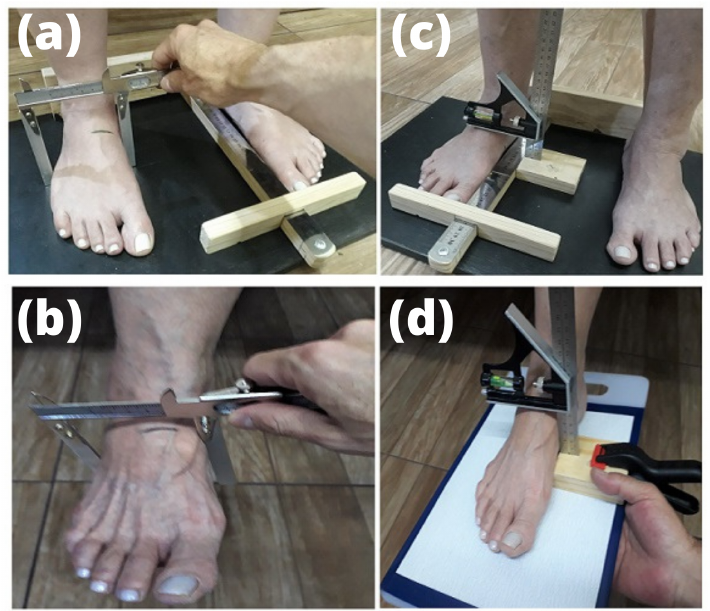
Figure 2. Morphology and anthropometric measurements to quantify the foot mobility magni- tude [32]: ( a ) midfoot width, weight-bearing; ( b ) midfoot width, non-weight-bearing; ( c ) foot arch height, weight-bearing; ( d ) foot arch height,